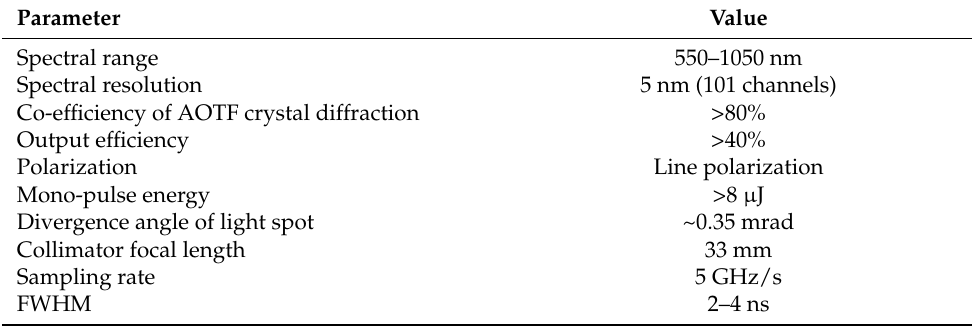
Figure 2. Test results of transmitted pulse energy stability on white reflectance standard board with 99% reflectivity. Table 1. System design criteria of HSL and waveform parameters.